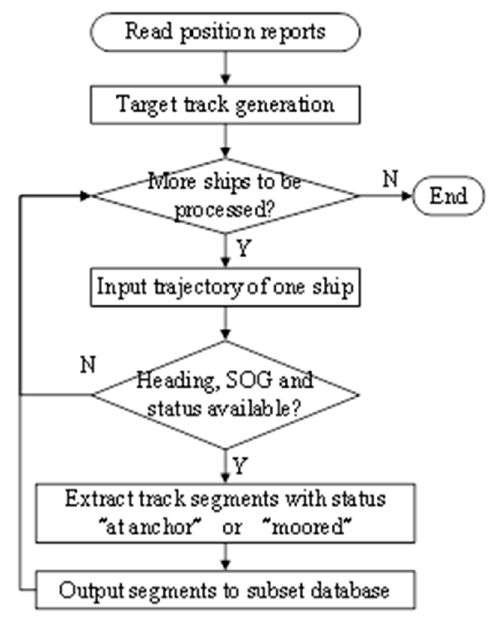
Figure 3. Process of high-quality historical data extraction, which outputs candidate berth mooring trajectories.